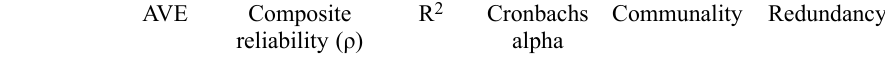
Table 3. Quality